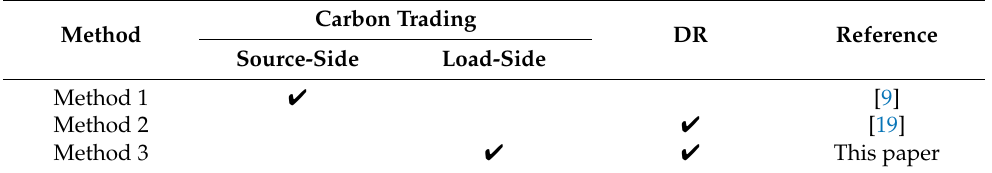
Table 6. Details of the three carbon reduction methods in the existing related research and this